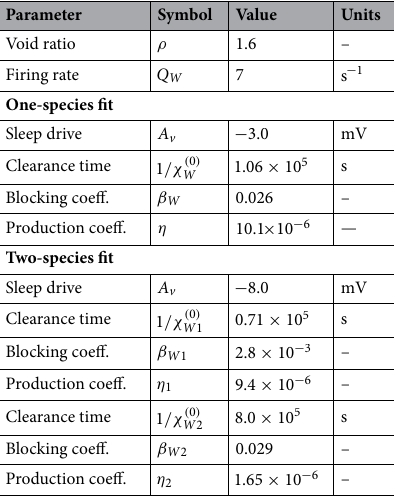
Table 1. Model parameters. Each line shows a parameter, its symbol, fitted value, and units in successive columns. Assumed homeostatic parameters are listed in the first block of the table. The second block shows parameters obtained from the one-species fit. The third block shows the corresponding two-species parameters. The full list of underlying circadian model parameters is found in 34